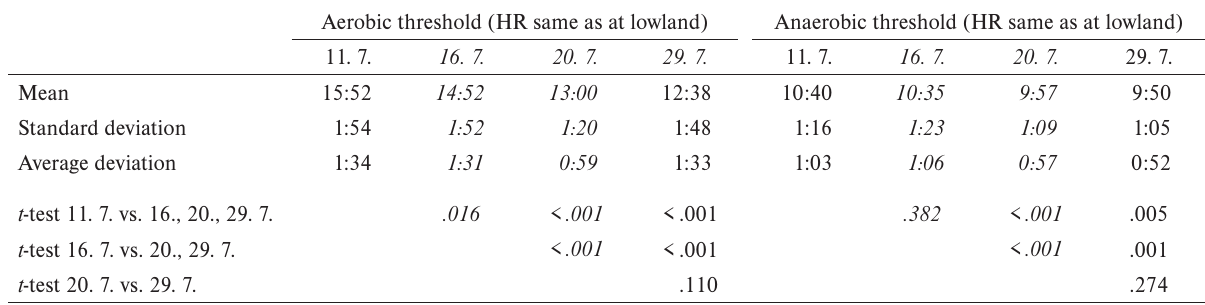
Summary of mean times achieved for individual tests at AP and ANP intensity with identical HR Aerobic threshold (HR same as at lowland)